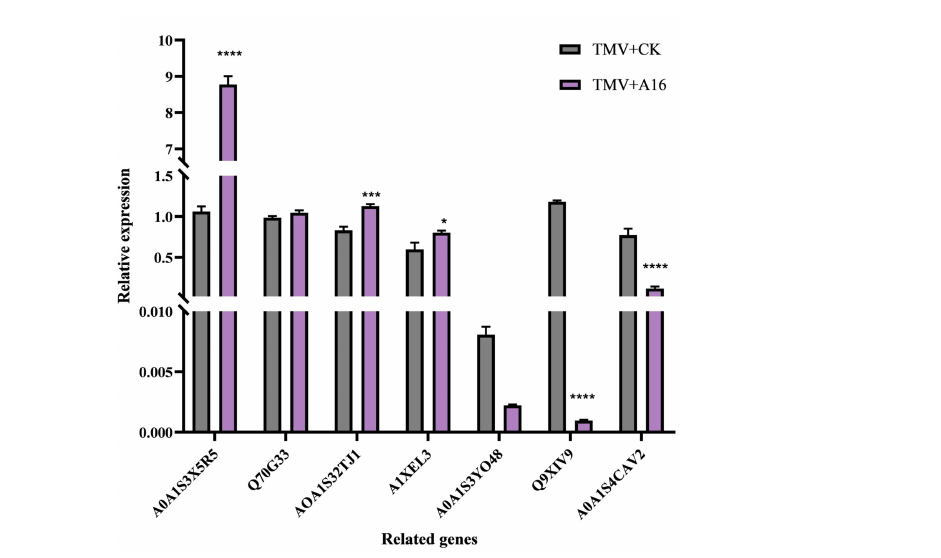
FIGURE 7 Gene expression analysis of the related genes of the phenylpropanoid biosynthesis by qRT-PCR. ( b -actin gene served as the internal control). Vertical bars refer to mean ± SD. ****", "***" and "*" represent signi fi cance at the 0.0001, 0.001 and 0.05 level,